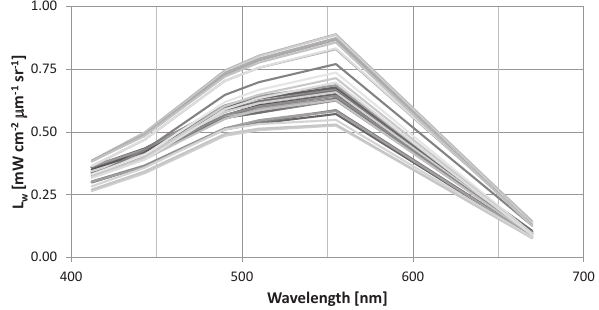
Fig. 1. L w (λ) spectra from WiSPER produced during the ARC ex- periment at the AAOT.